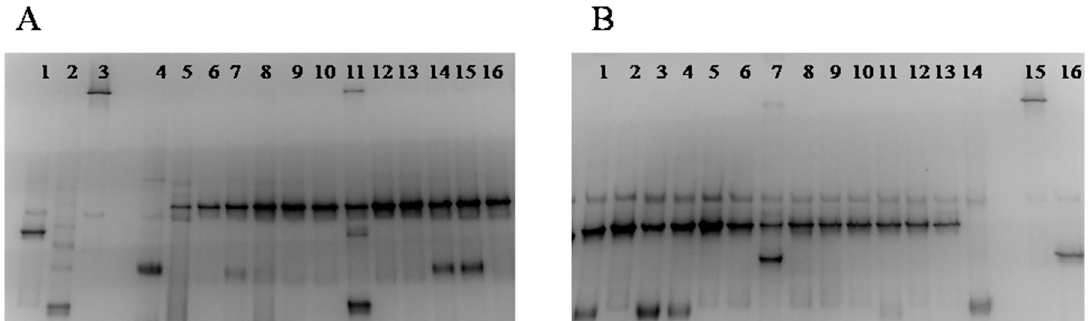
Figure 7. Yeast DGGE profiles of nucleic acids extracted directly from sourdough samples. ( A ): DNA.